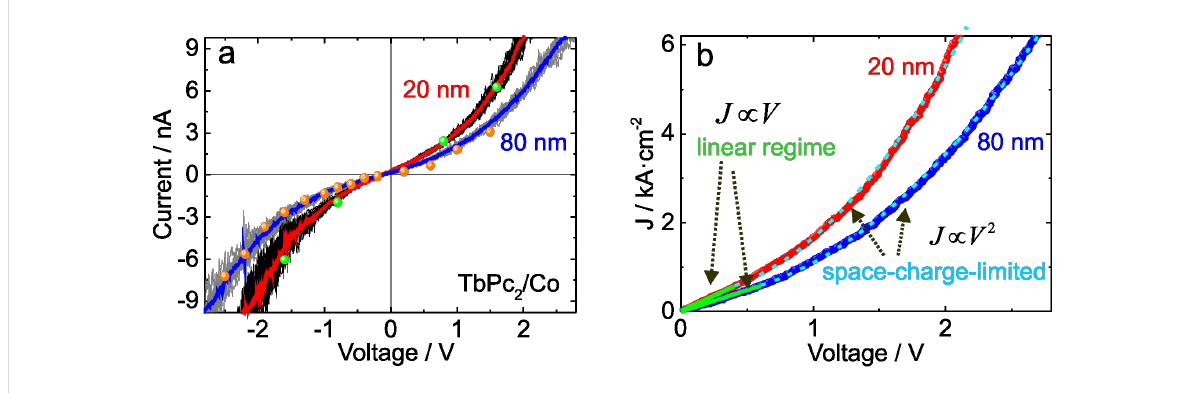
Figure 7: Transport mechanism for TbPc 2 thin films. Red and blue solid lines indicate the average of 20 local I–V spectroscopy cycles. (a) Current–voltage characteristics for TbPc 2 thin films. Grey and black data in (a) represent the local I–V spectroscopy cycles. Dotted data represent the current value obtained via current maps. Each dot represents the average of 512 × 512 data points acquired during the AFM scanning. (b) Current density response. Solid green lines and dashed blue lines correspond to the linear and space-charge-limited transport regimes, respectively.